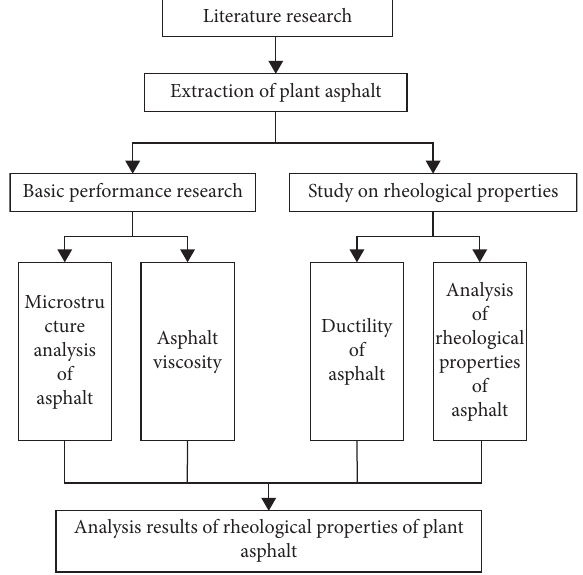
Figure 1: Technical route design of rheological property analysis of plant